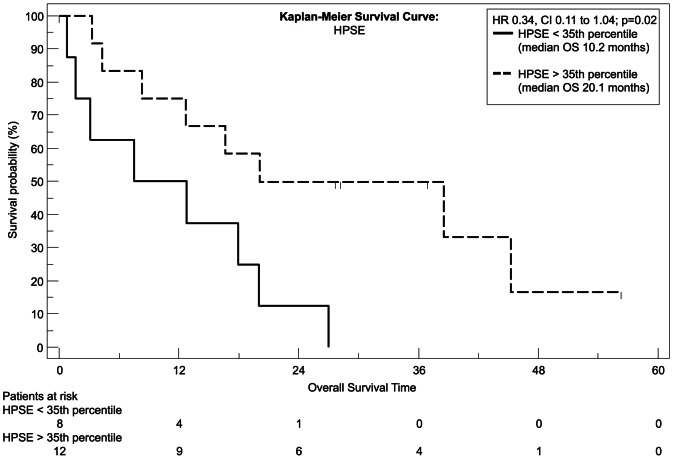
Kaplan-Meier plot, estimating overall survival.Differences in survival between the high (interrupted line) and the low (continuous black line) HPSE expression group were analyzed with the log-rank test.